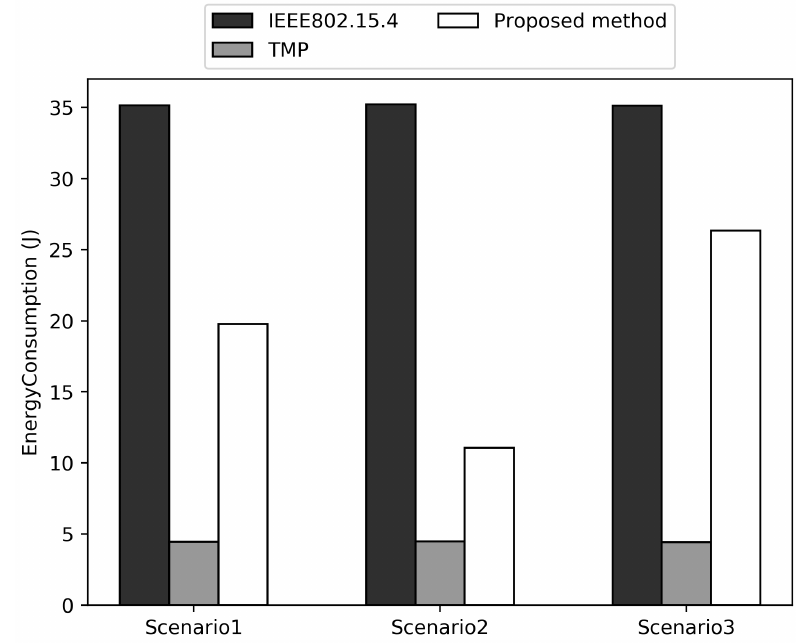
Figure 14. Energy consumption of each